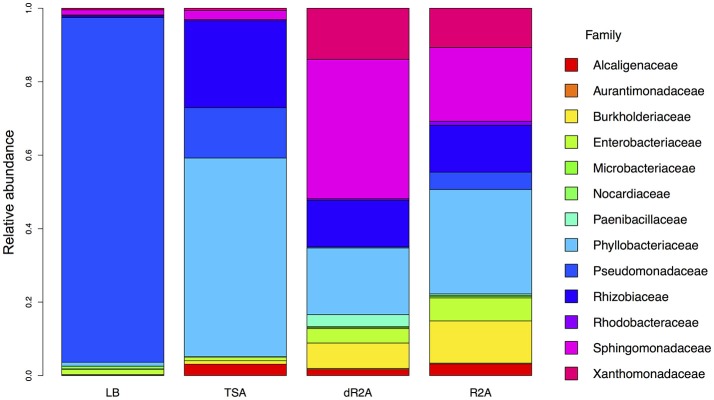
Stacked barplot showing the relative abundance, across toads/replicates within each culture media, of the taxonomic families of the indicator OTUs associated with the distinct culture media types.